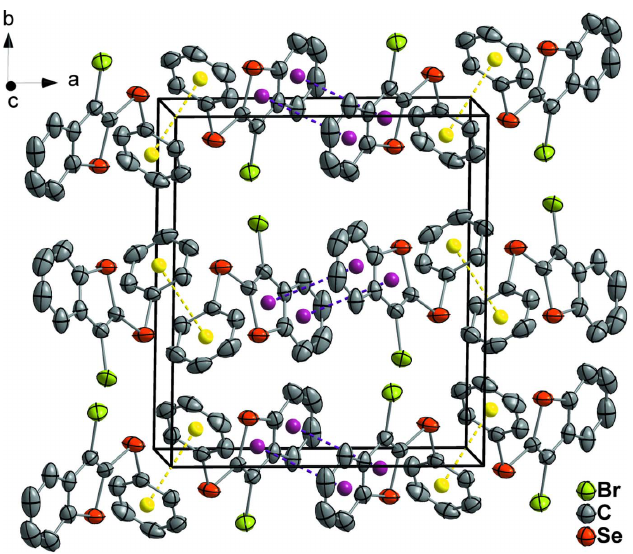
Figure 10 Representation of the molecules of 3-bromo-2-(phenylselanyl)benzo- [ b ]selenophene ( 3 ) viewed down the c axis of the unit cell. The purple and yellow dashed lines represent (cid:3) – (cid:3) stacking interactions between adjacent benzo[ b ]thiopehene rings and between adjacent phenylsulfanyl groups, respectively. Displacement ellipsoids are drawn at the 50% probability level. The hydrogen atoms were omitted to clarity. Purple and yellow spheres represent the centroids of the respective organic